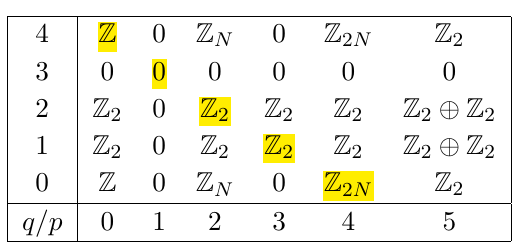
Table 2 . E 2 page of even N